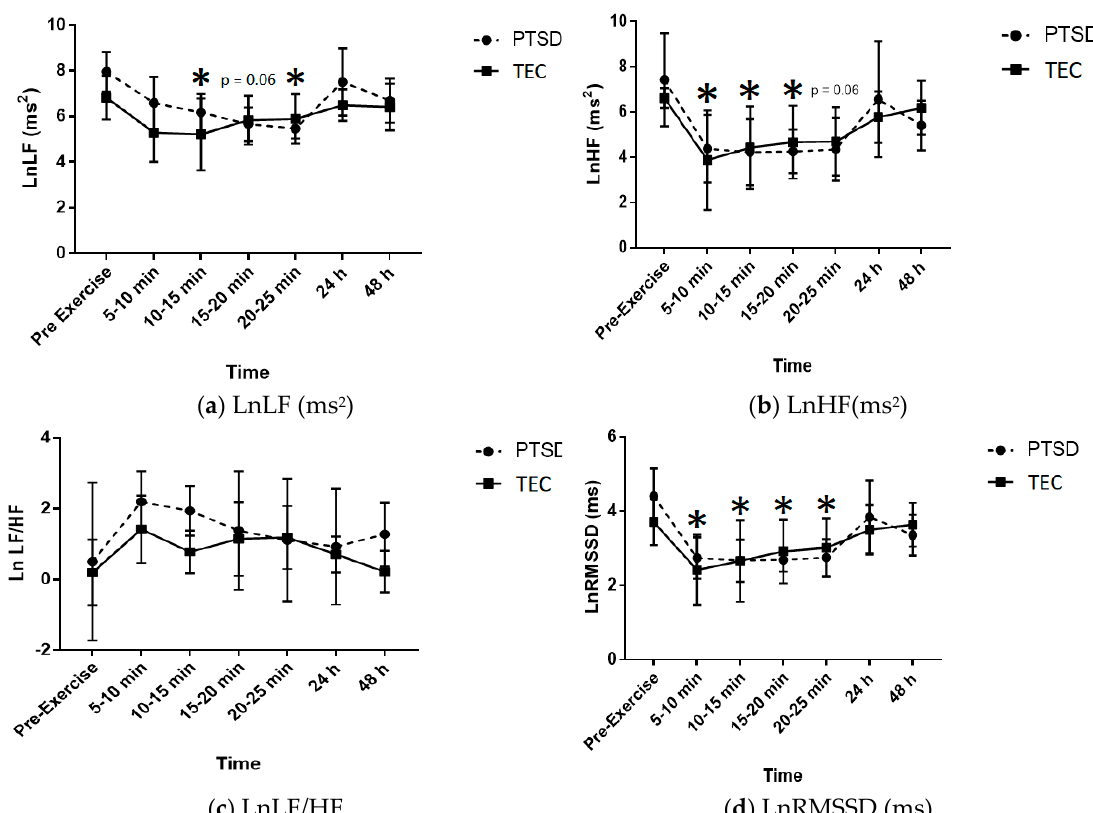
Figure 2. ( a – d ): Measured HRV parameter values immediately prior to and following the exercise protocol. Note: PTSD: post-traumatic stress disorder; TEC: trauma-exposed controls; LnLF: natural log of low frequency power; LnHF: natural log of high frequency power, LnLF/HF: natural log of low frequency power to high frequency power ratio; LnRMSSD: natural log of the square root of mean squared differences of successive R-R intervals (* denotes significance p ≤ 0.05).